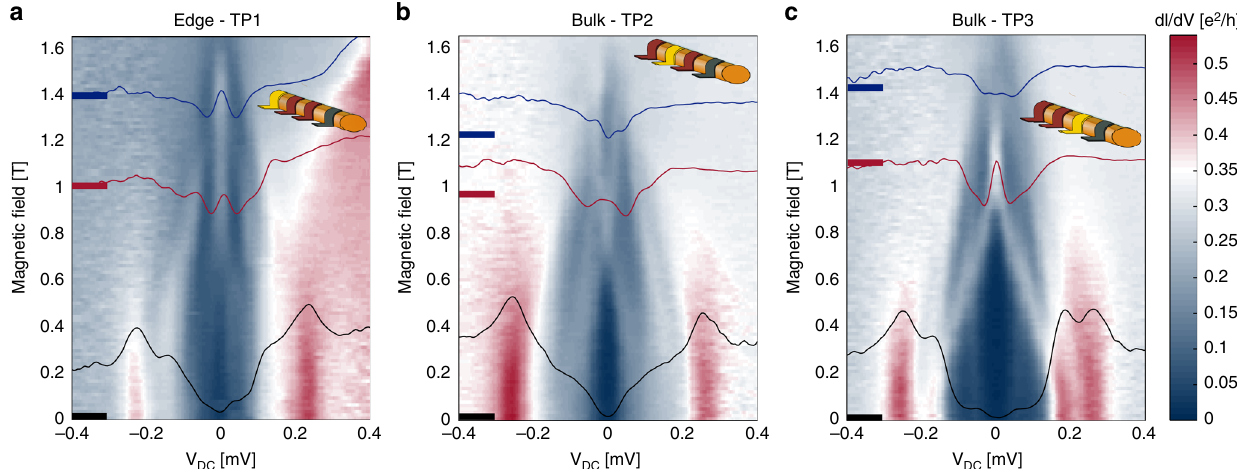
Fig. 2 Conductance spectroscopy at the edge and at the bulk of the nanowire. Conductance as a function of the DC bias V DC and the magnetic fi eld B , measured by three tunnel probes: a TP1 — edge, b TP2 — bulk, and c TP3 — bulk. The active tunnel probe is colored in yellow in the inset of each plot. Measurements were performed on two TPs simultaneously ( fi rst TP1 and TP2, then TP1 and TP3), while the third TP kept fl oating. Cuts of the 3D plot at three different magnetic fi elds (marked by thick lines) are drawn on top (black, red and blue). a At the edge, a ZBCP appears at B ∼ 0.7 T and persists until 1.6 T. b In the bulk, the trivial gap closes at B ∼ 0.7 T and reopens (as a topological gap) at B ∼ 1.05 T, with E g = 65 µ eV at B = 1.4 T. c The trivial gap closes at B ∼ 0.95T and reopens at B ∼ 1.4 T, with E g = 30 µ eV. In all the measurements, the back-gate voltage is V BG = − 4.22 V. The two bulk TPs have the same induced gap (though softer in TP2), while at the edge TP, it is slightly smaller. The color scale is common to the three